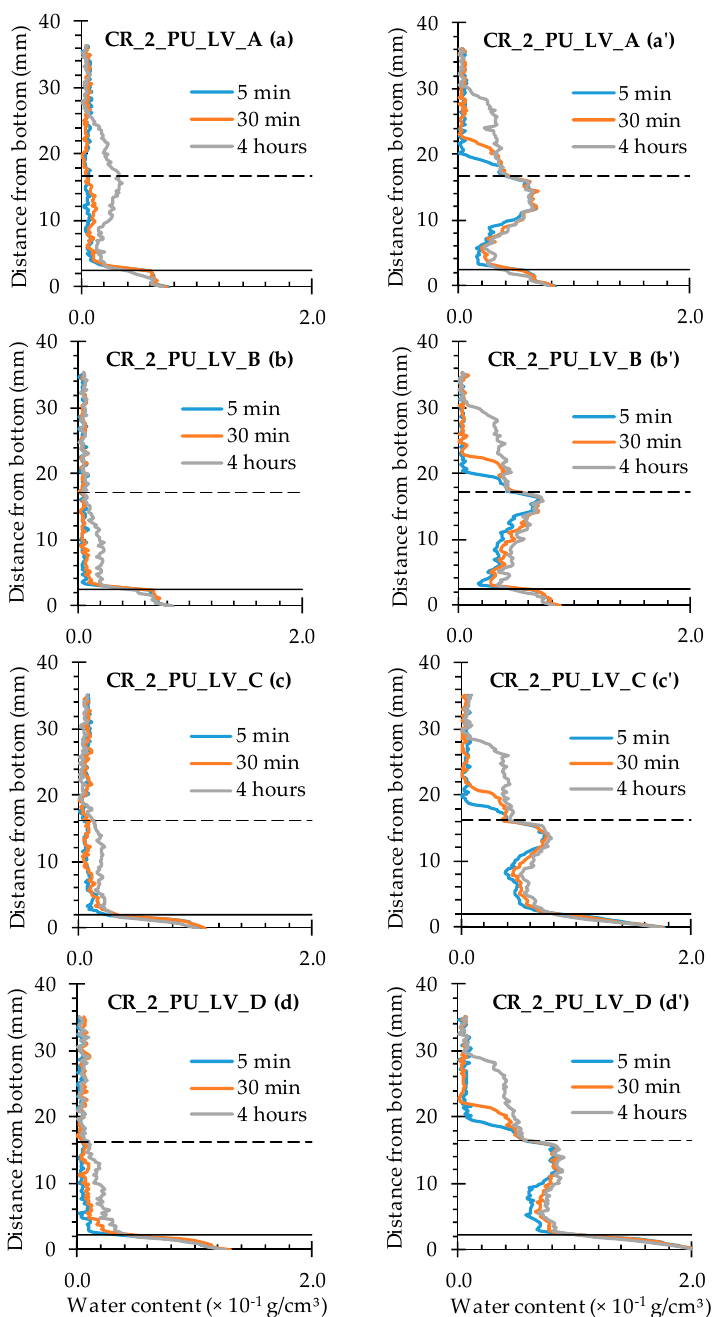
Figure 21. Water profiles along the crack as a function of exposure time for the neutron radiography images of the four standard mortar prisms containing two artificial cracks healed with PU_LV: ( a ) CR_2_PU_LV_A crack on the left; ( a’ ) CR_2_PU_LV_A crack on the right; ( b ) CR_2_PU_LV_B crack on the left; ( b’ ) CR_2_PU_LV_B crack on the right; ( c ) CR_2_PU_LV_C crack on the left; ( c’ ) CR_2_PU_LV_C crack on the right; ( d ) CR_2_PU_LV_D crack on the left; and ( d’ ) CR_2_PU_LV_D crack on the right.